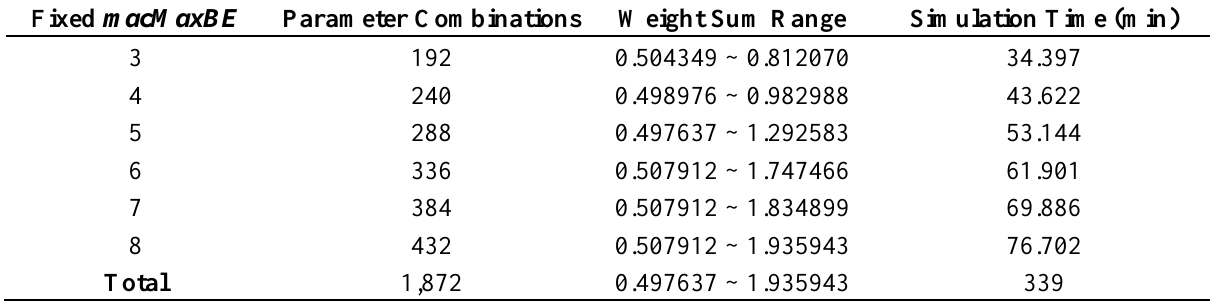
Table 3. Exhaustive/Full simulation